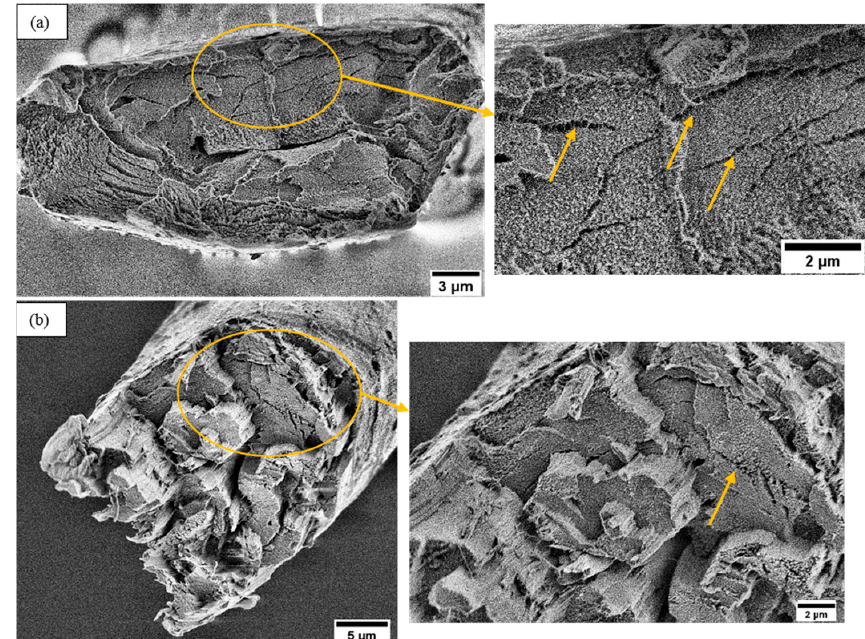
Figure 9. LV-SEM images of the fractured surface of single ramie fibers under tensile load ( a ) overview of a flat fractured surface with a detail cell wall structure inside yellow circle ( b ) overview of an irregular fractured surface with a detail cell wall structure inside yellow circle. Yellow arrows highlight cracks.